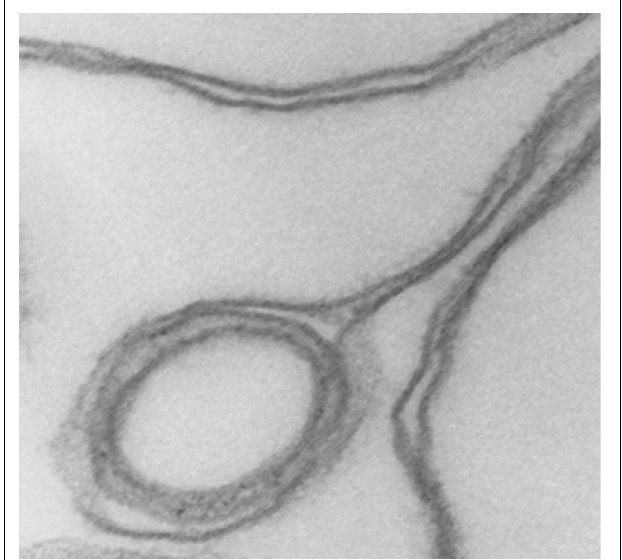
FIGURE 2 | Headphone shape samples. Transmission electron micrograph of selected collapsed vesicles showing the close apposition of the cytoskeleton-free membranes outlining the “headphone” shapes in longitudinal sections. Note the massive reduction in the intra-vesicular space, the outline of the 3D cup shape of the collapsed vesicles, and the displacement of contents toward the rim of the cup. 67,500x.